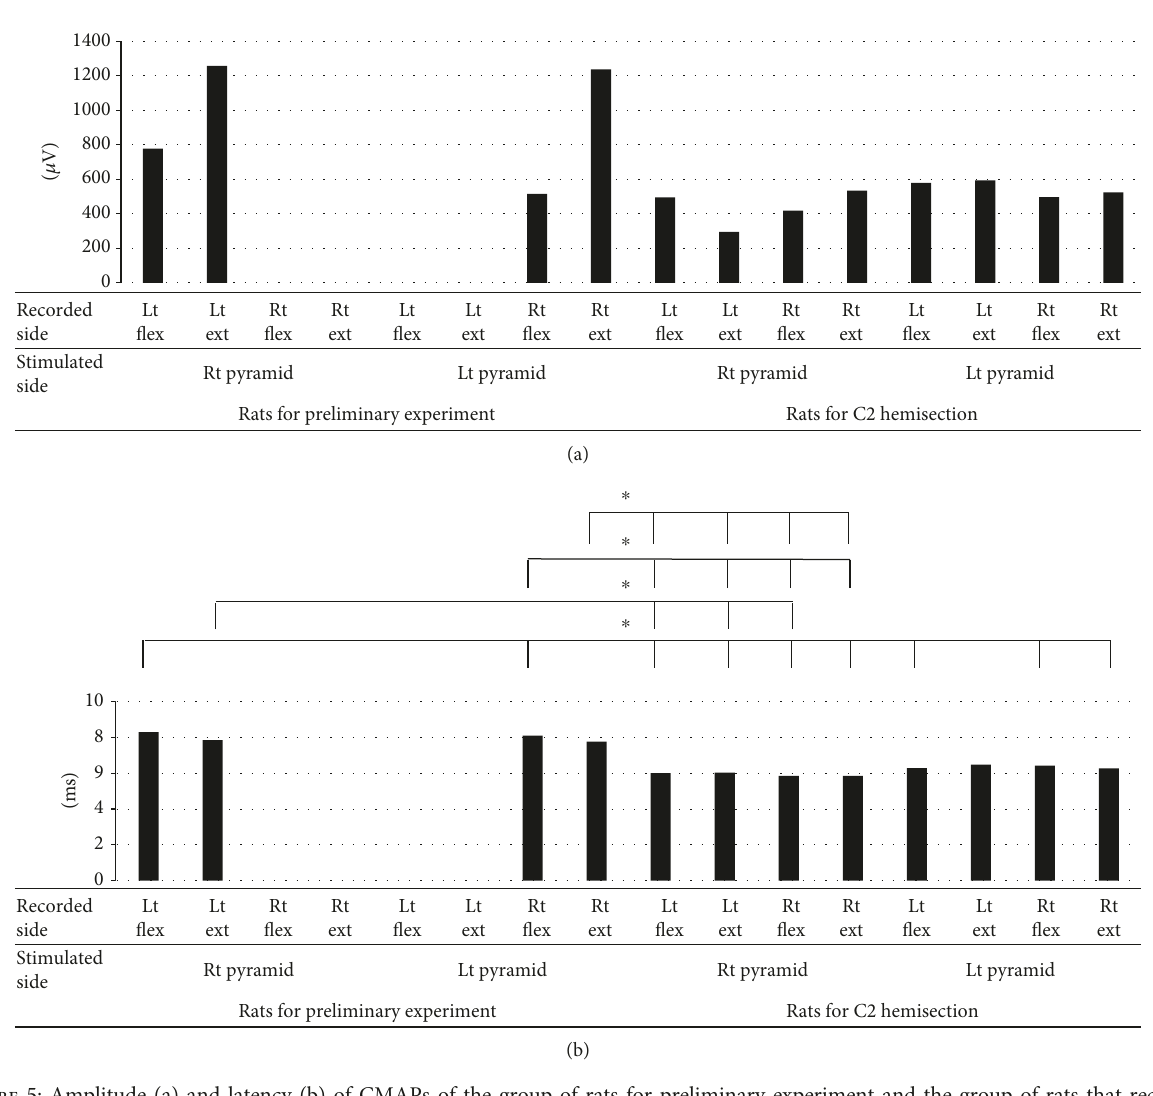
Figure 5: Amplitude (a) and latency (b) of CMAPs of the group of rats for preliminary experiment and the group of rats that received additional C2 hemisection. (a) No signi fi cant di ff erence was found in the amplitude between the rats for preliminary experiment and the rats that received additional C2 hemisection. (b) Meanwhile, a signi fi cant shortening of latency was found in the rats that received C2 hemisection ( ∗ p < 0 05 ). CMAPs: compound muscle action potentials; Rt: right; Lt: left; Flex: fl exor; Ext: